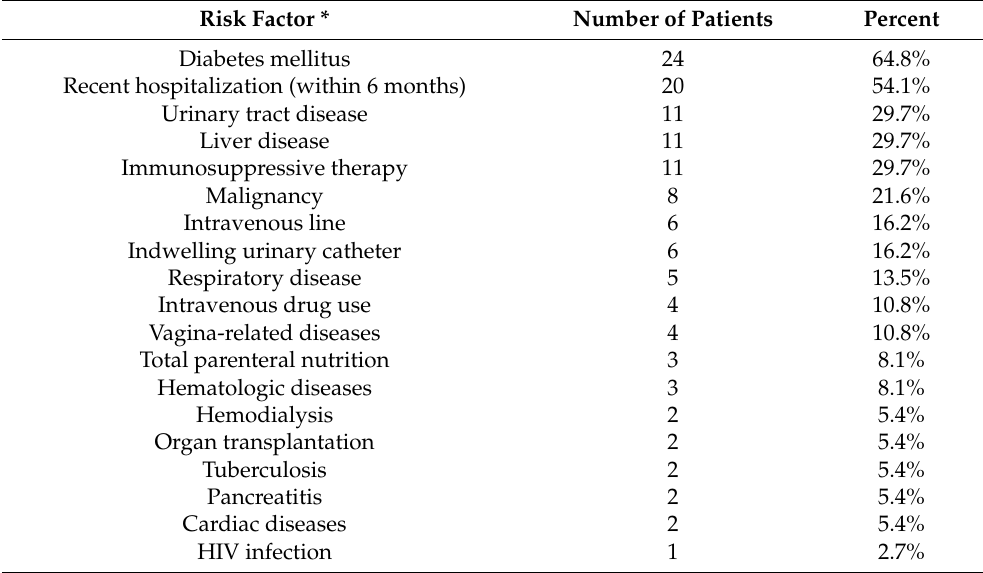
Table 3. Risk factors of endogenous fungal